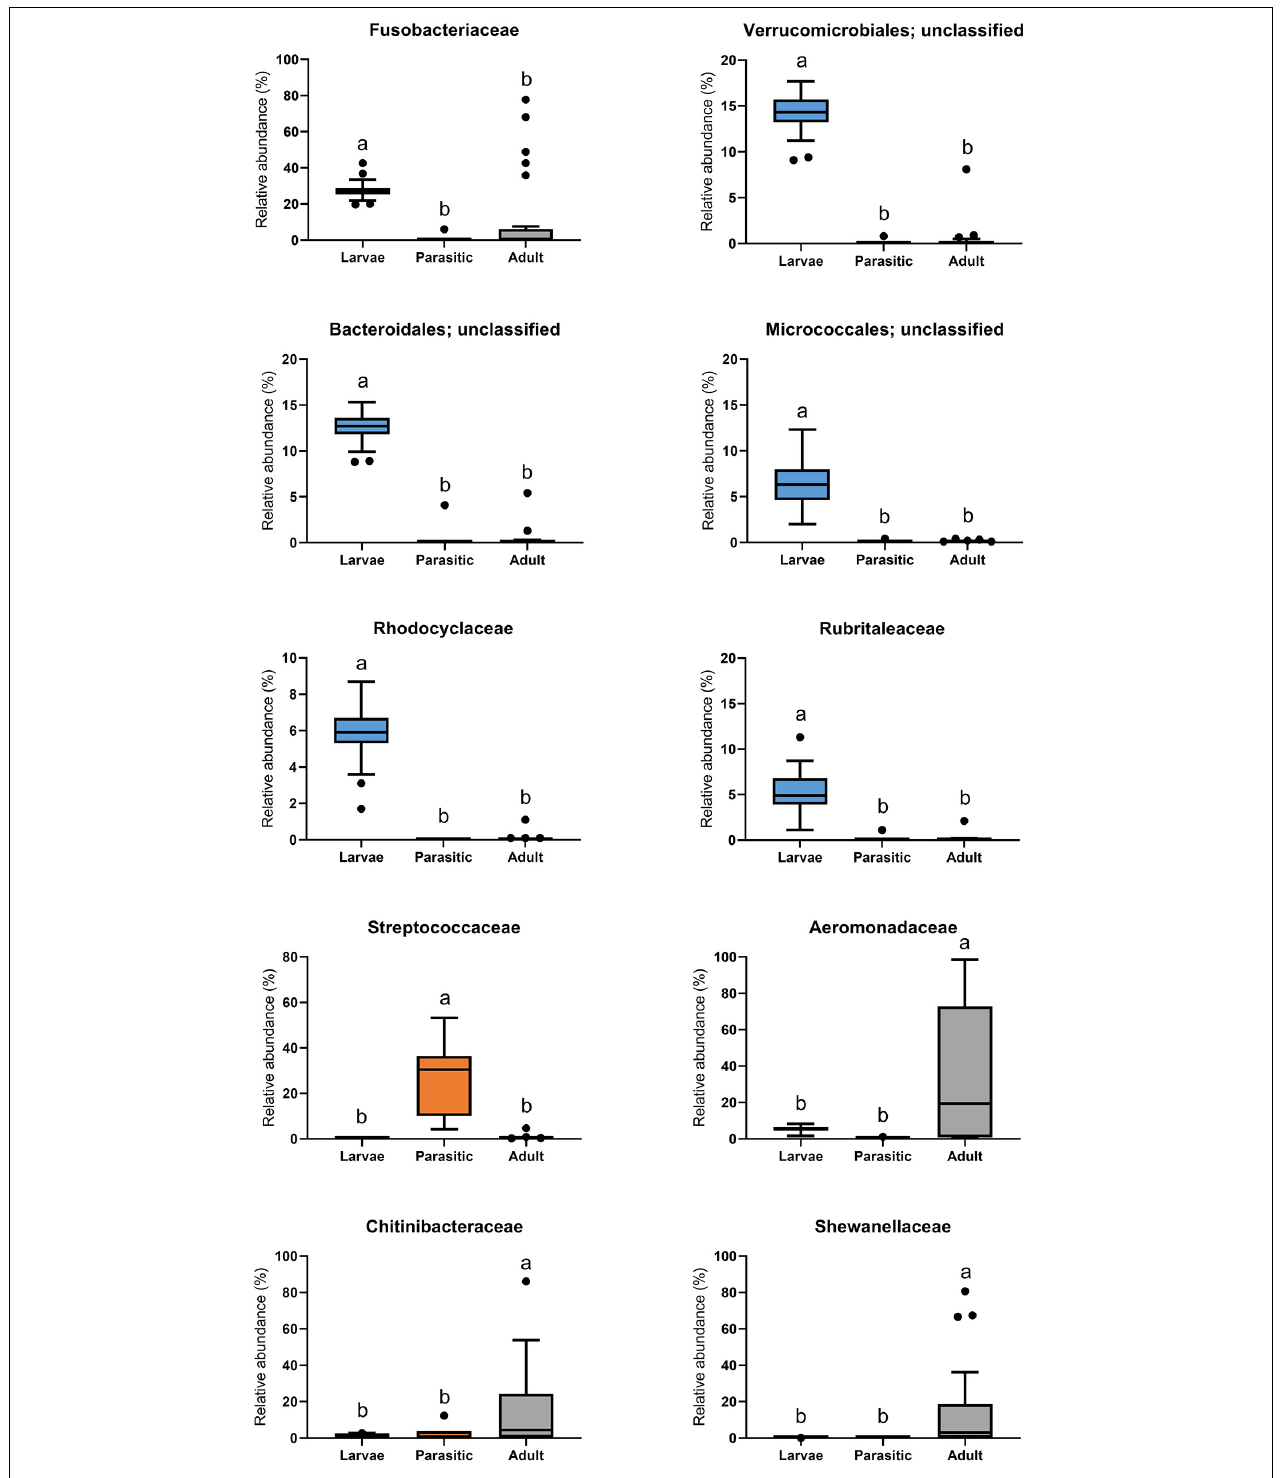
FIGURE 4 | Family-level classification of microbial communities associated with larval, parasitic, and adult sea lamprey ( Petromyzon marinus ). All taxa present in ≥ 5% relative abundance in an individual SL are shown in this graph.